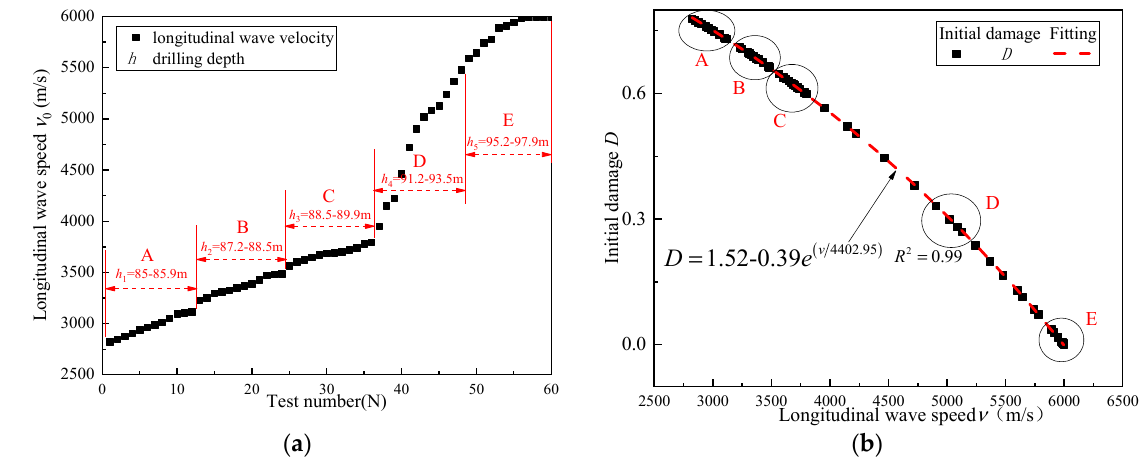
Figure 2. Longitudinal wave velocity and damage degree of rock samples at five sampling depths: ( a ) Longitudinal wave velocity; ( b ) Damage degree.